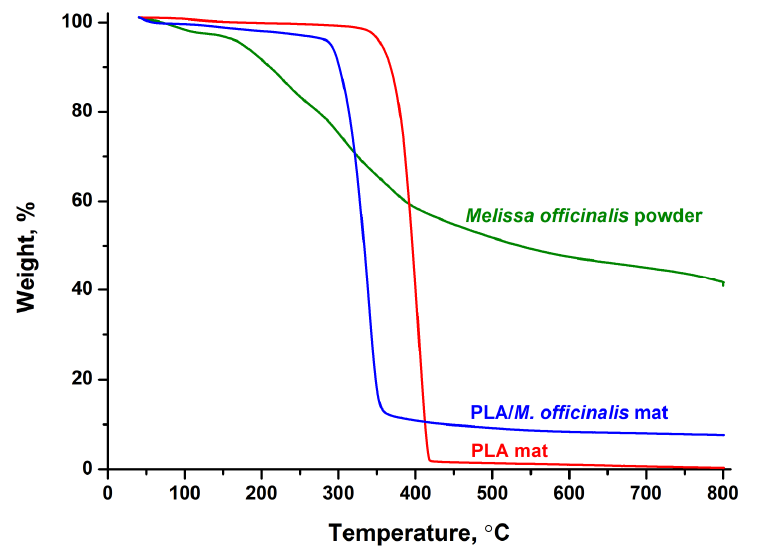
Figure 7. TG thermograms of: Melissa officinalis powder, PLA mat and PLA/ M. officinalis mat in the range 50 to 800 °C.